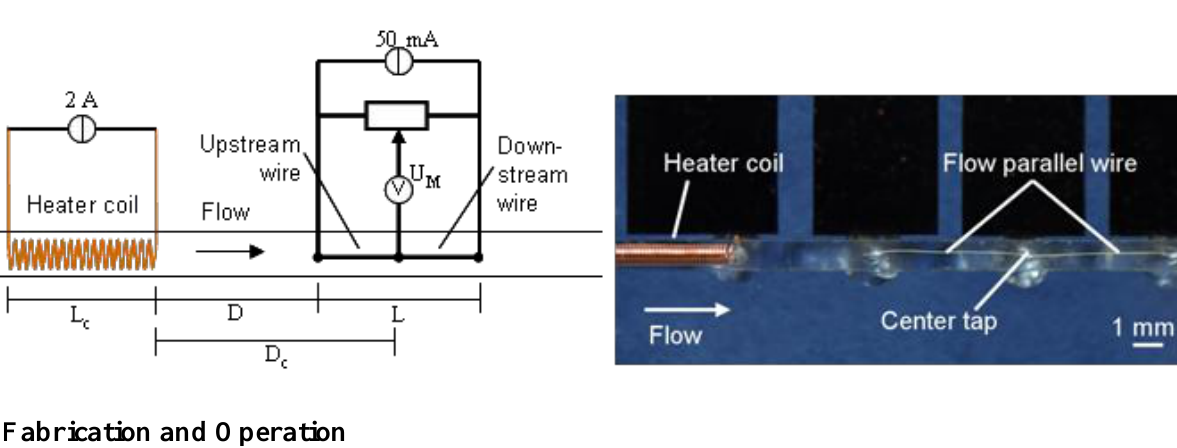
Figure 1. Time of flight sensor employing a sensor wire parallel to the channel shown as a schematic drawing ( left ) and a photo ( right ).